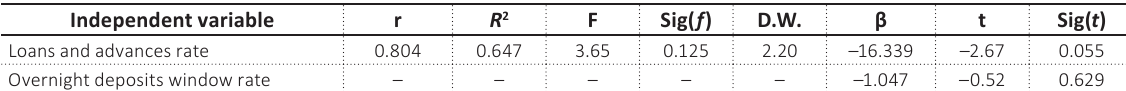
Table 7. Multiple linear regression for testing the effect of the Central Bank of Jordan on the liquidity ratio of banks operating in Jordan